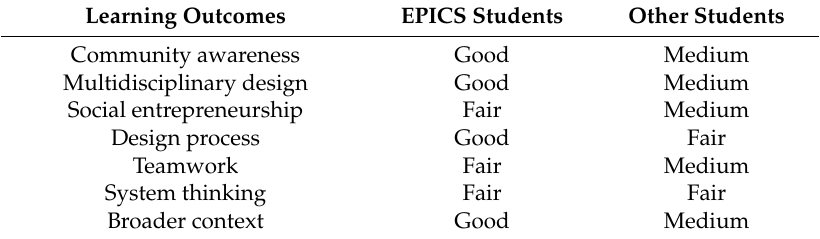
Table 6. Comparison between EPICS students and other students in three levels (good, fair,